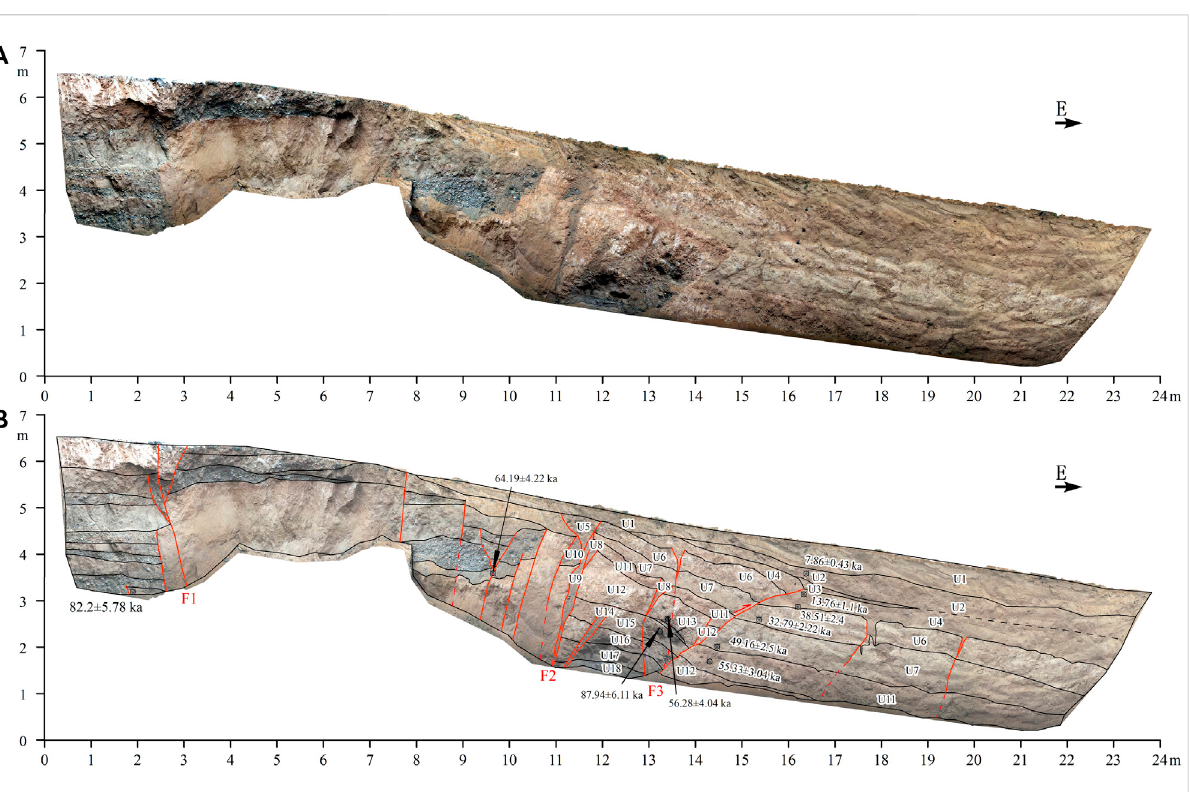
FIGURE 4 North wall of Sumutu south trench. (A) Mosaic photographs; (B) pro fi le, see main text for unit